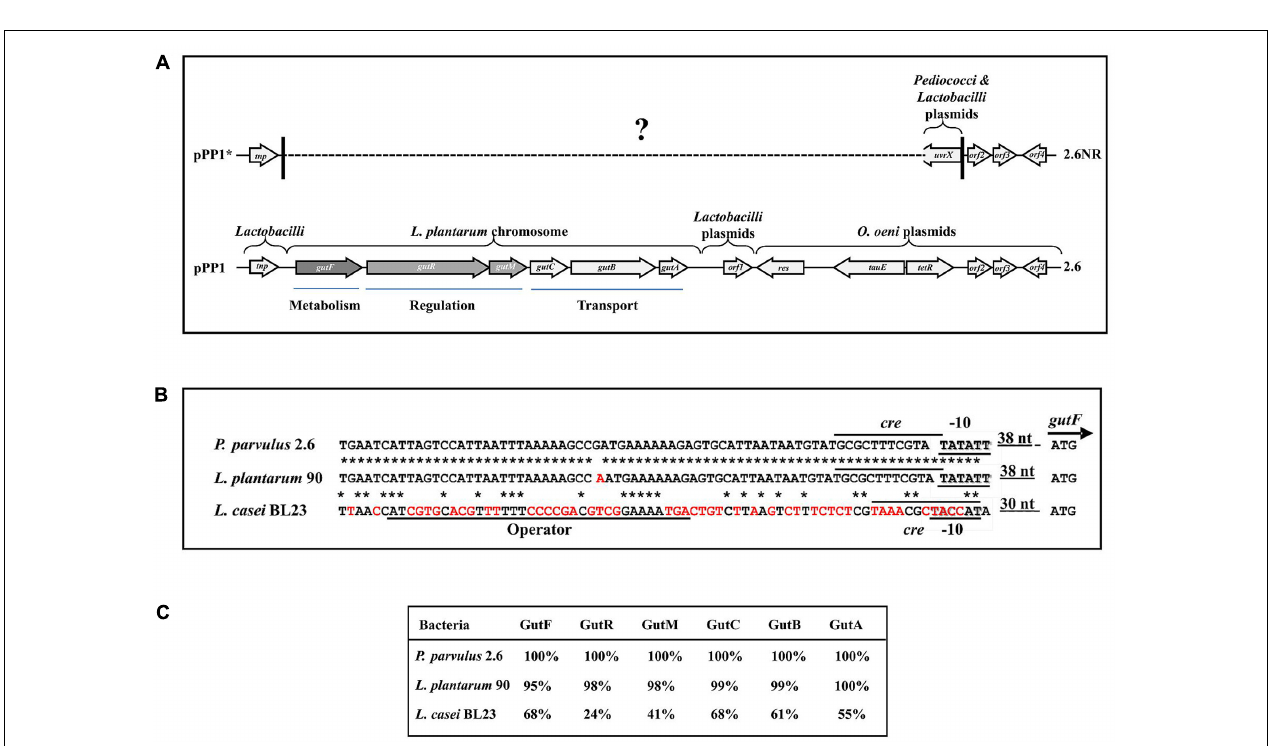
FIGURE 6 | The sorbitol operon and flanking DNA regions of P. parvulus 2.6. (A) Sequenced regions of pPP1 and pPP1 ∗ plasmids are shown. Genes and ORF are depicted and homologies at the nucleotide level are indicated (see details in the text). ? Indicates unknown sequence. Homology of regulatory genetic regions (B) and proteins (C) involved in sorbitol utilization between P. parvulus 2.6, L. plantarum 90 and L. casei BL23 is shown. (B) DNA sequences of: the putative P gut promoters (–10 boxes) and the GutR operator of L. casei are underlined; the putative cre sequences for catabolic repression are overlined; also the start codon (ATG) of gutF gene and the nucleotides between this and the –10 boxes are depicted. Red letters indicate mismatches with the P. parvulus 2.6 DNA sequence. ∗ Means identity of nucleotides. (C) Identity of the amino acid sequence of the Gut proteins from L. plantarum 90 and L. casei BL23 with those of P. parvulus 2.6 is